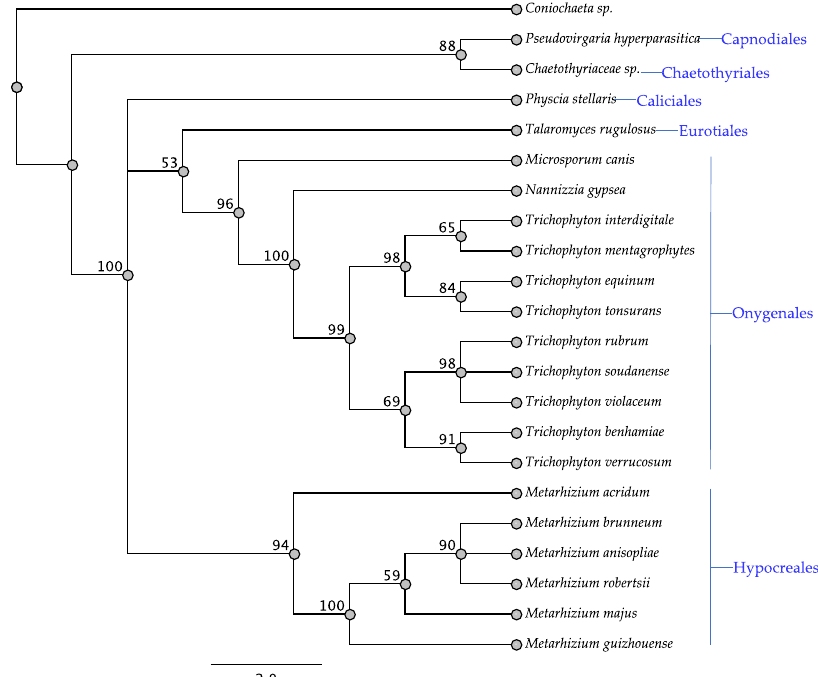
Figure 6. Maximum parsimony protein tree resulting from the analysis of SwnA. Bootstrap confidence values from 1000 bootstrap replicates are presented at each corresponding node. Coniochaeta sp. (Hypocreales) was used as the outgroup and obtained from NCBI database, GenBank accession: KAB5525774.1. Fungal orders are indicated next to each organism/clade.